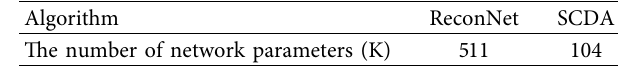
Table 8: The average time required for the reconstruction process (the measurement rate is 0.01).